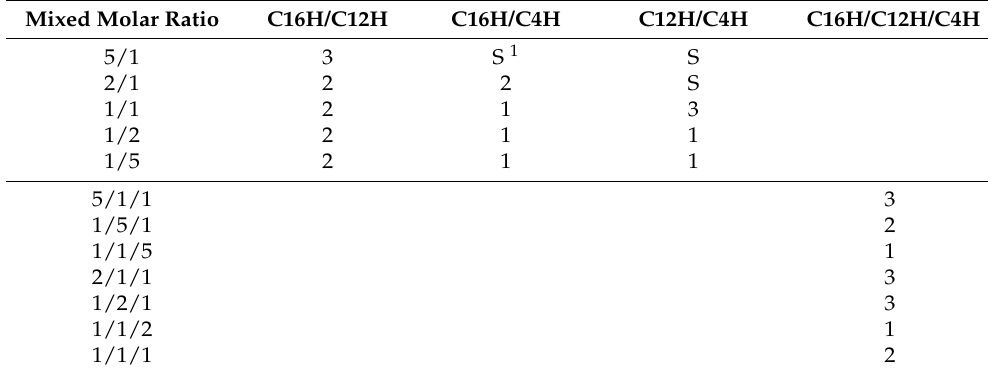
Table 2. Critical gel concentrations (CGC, wt.%) of mixed N -alkylhydantoin systems in squalane. Mixed Molar Ratio